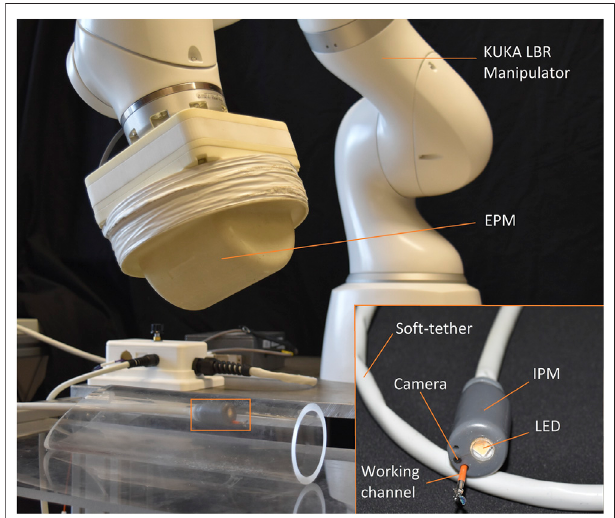
FIGURE 1 | Overview of the MFE system. The magnetic endoscope (bottom right) contains a camera, LED, and a working channel. A KUKA LBR Med robotic arm actuates the MFE via manipulating an external permanent magnet mounted to its